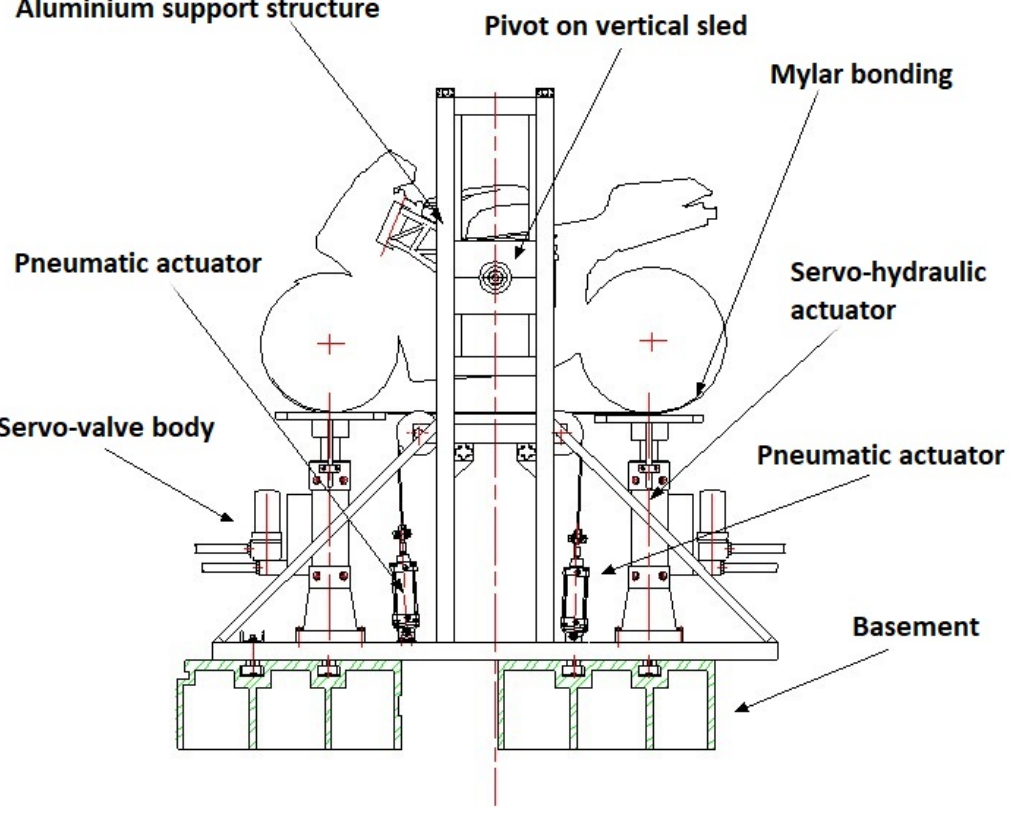
Figure 4. Schematic picture of the restraint system.